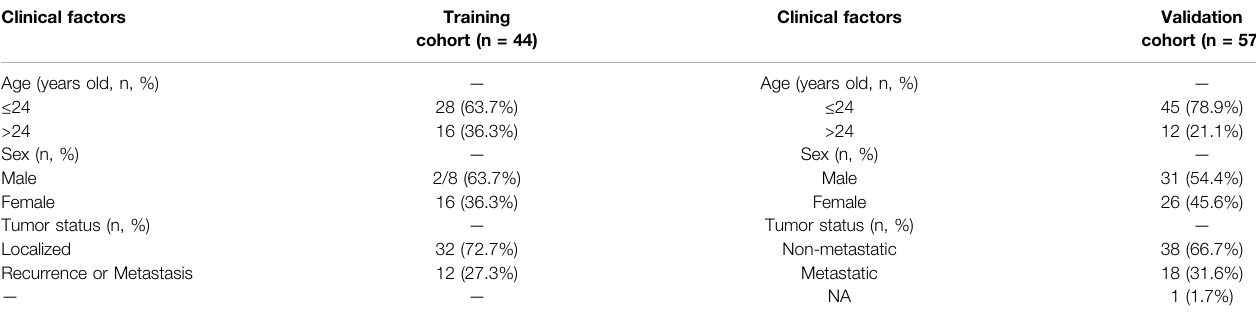
TABLE 1 | Clinical characteristics of patients in the training and validation cohort. Clinical